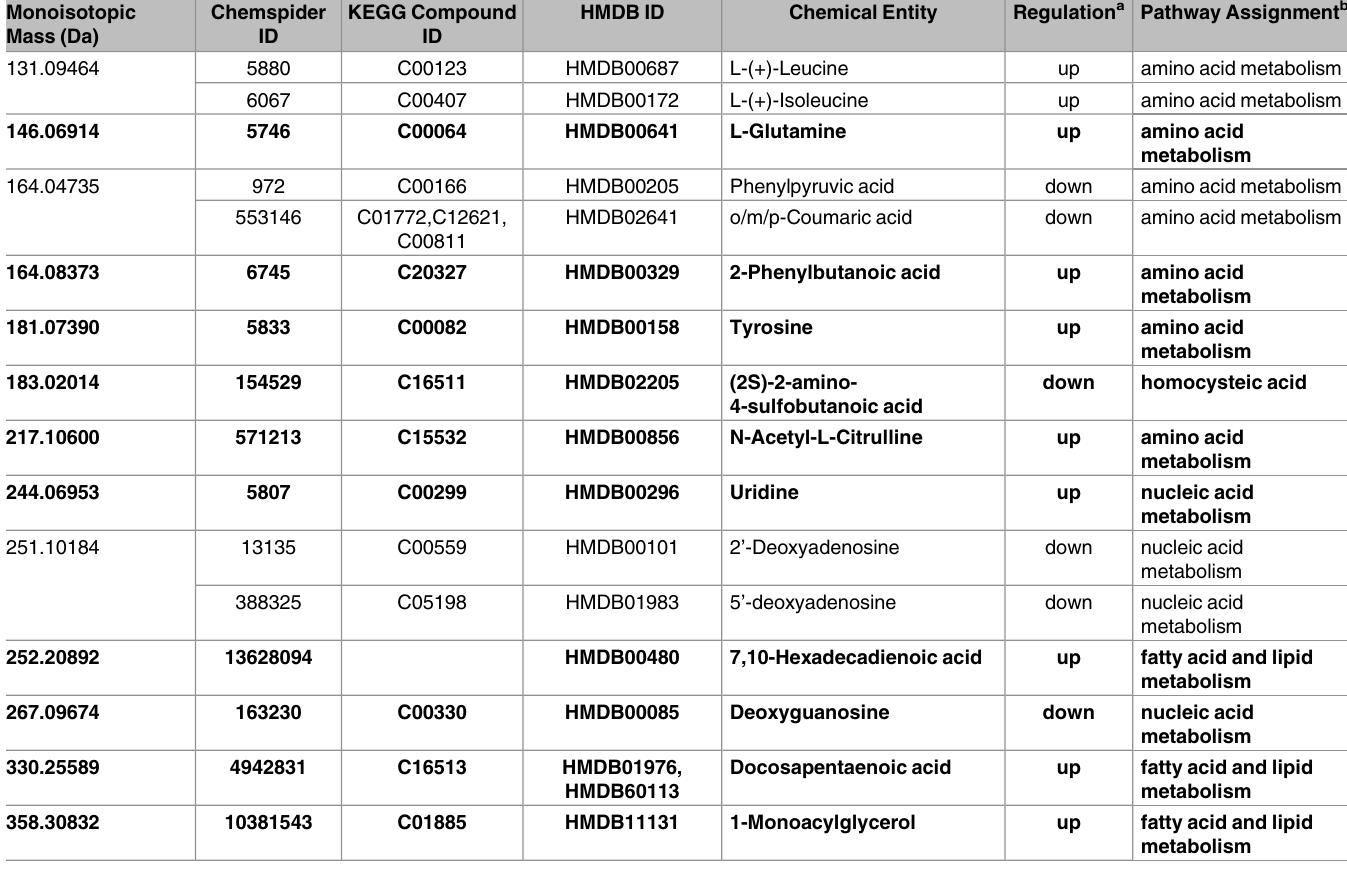
Table 3. Metabolomic analysis of peritoneal effluents following treatment with standard PDF vs . PDF with 8 mM AlaGln. Monoisotopic Mass